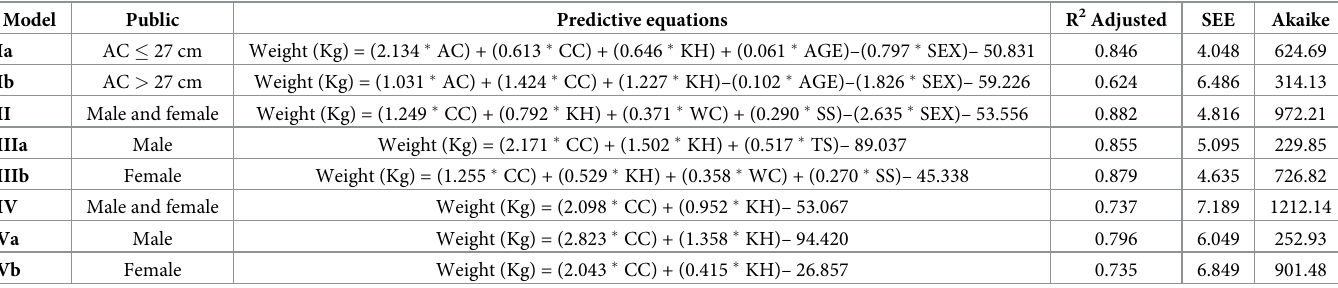
Table 3. Equations for weight estimation using anthropometric variables in older adults.